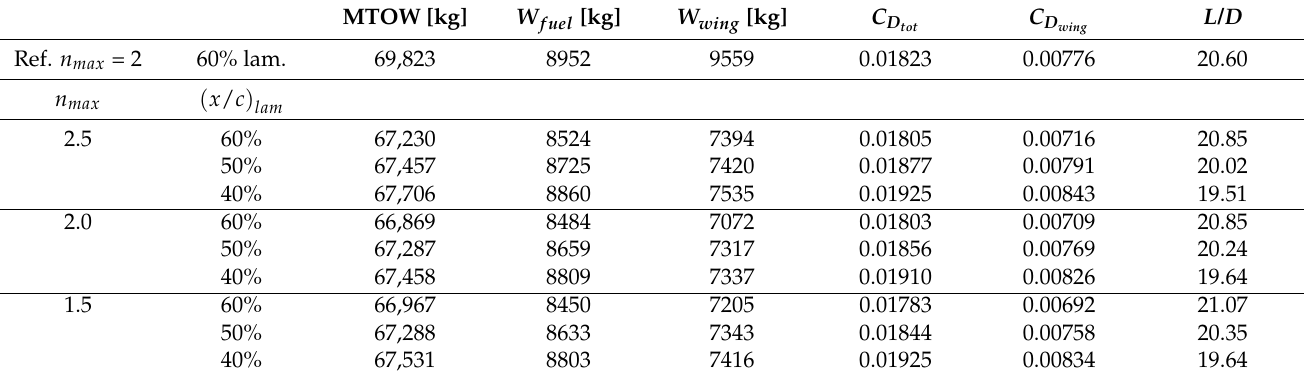
Table 6. SE 2 A midrange forward-swept wing optimisation results.